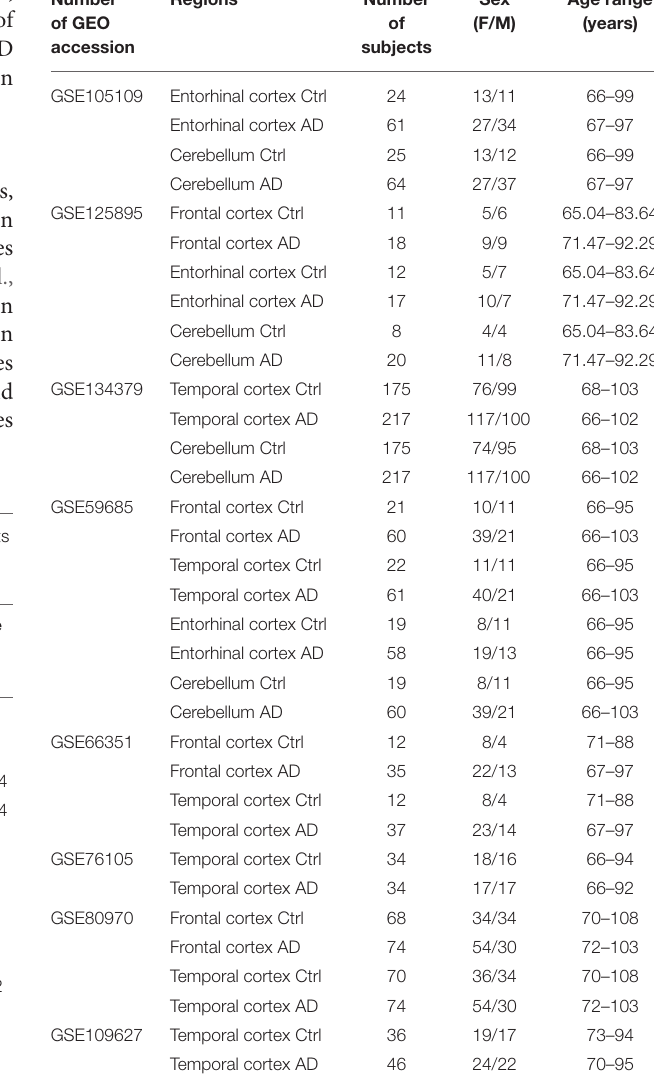
TABLE 2 | Characteristics of the Infinium450k datasets investigated in the present study including AD patients and non-demented control